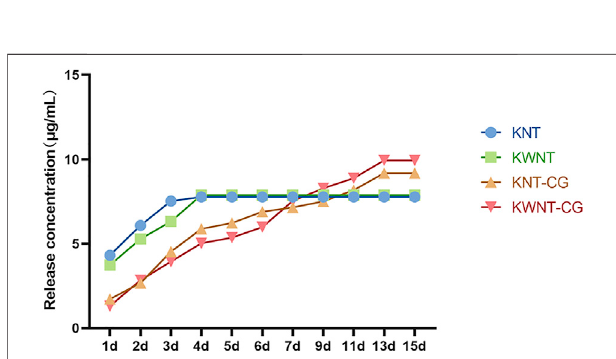
FIGURE 6 | Cumulative release curve of titanium tablets loaded with kaempferol.